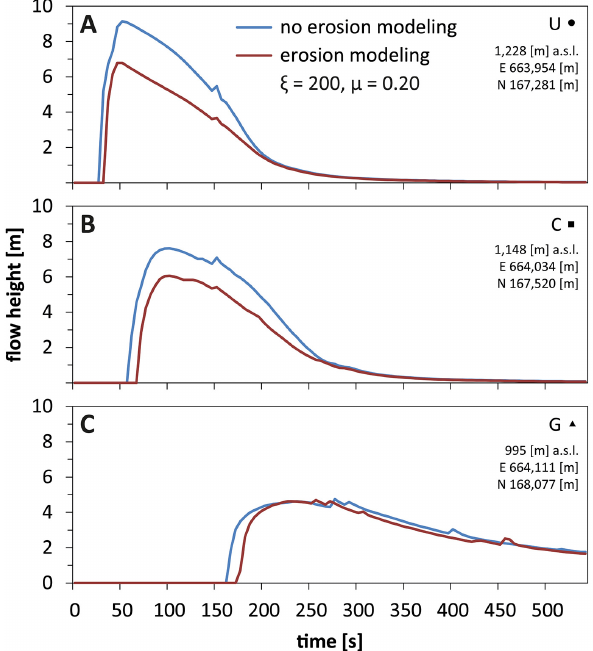
Figure 6. Comparison of modeled flow height for the second event on 10 August 2010 (Table 1) using no-erosion modeling (blue lines) and erosion modeling (red lines) with distance along the channel. The different modeling locations (U, C, G) are shown in Fig. 5.